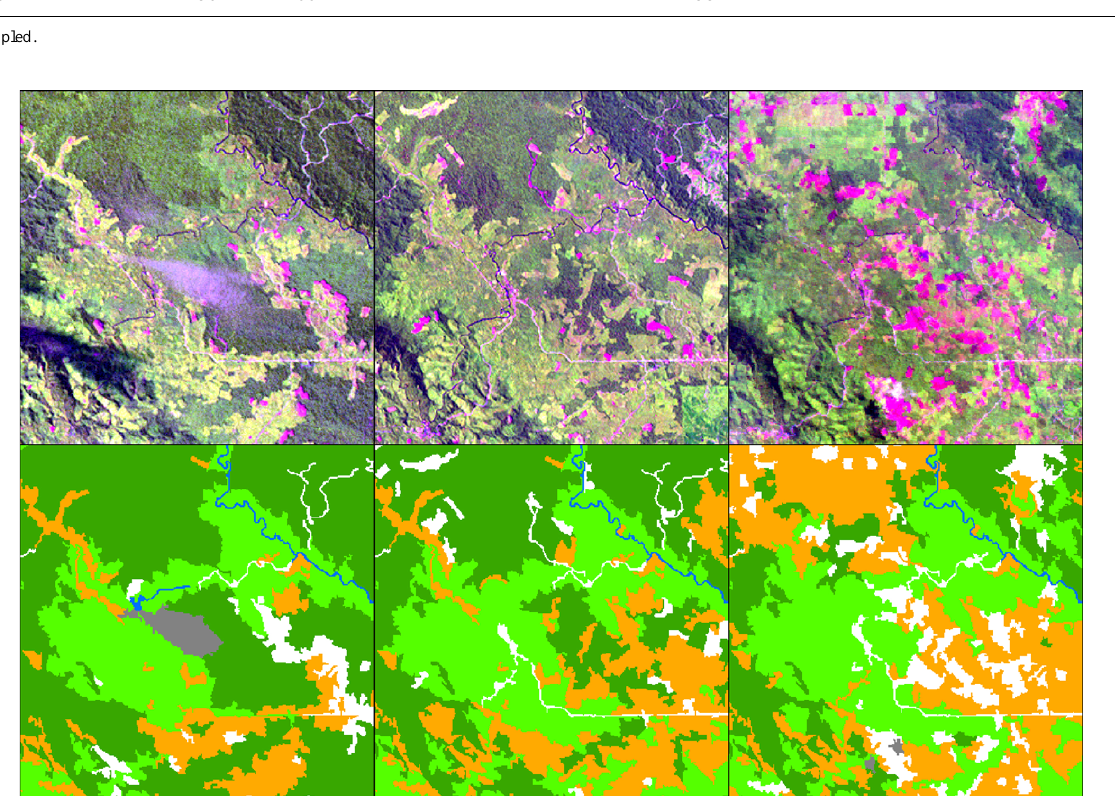
Fig. 2. Example of image and mapping results for a sample site (10km × 10km) on Borneo (0 ◦ N, 101 ◦ ). (top panels) Landsat TM and ETM + satellite imagery for reference years 1990 (left), 2000 (middle) and 2010 (right). (bottom panels) Corresponding land cover maps: dark green = “Tree Cover”, bright green = “Tree Cover Mosaics”, orange = “Other Wooded Land”, white = “Other Land”, dark grey = Cloud, Smoke; blue =